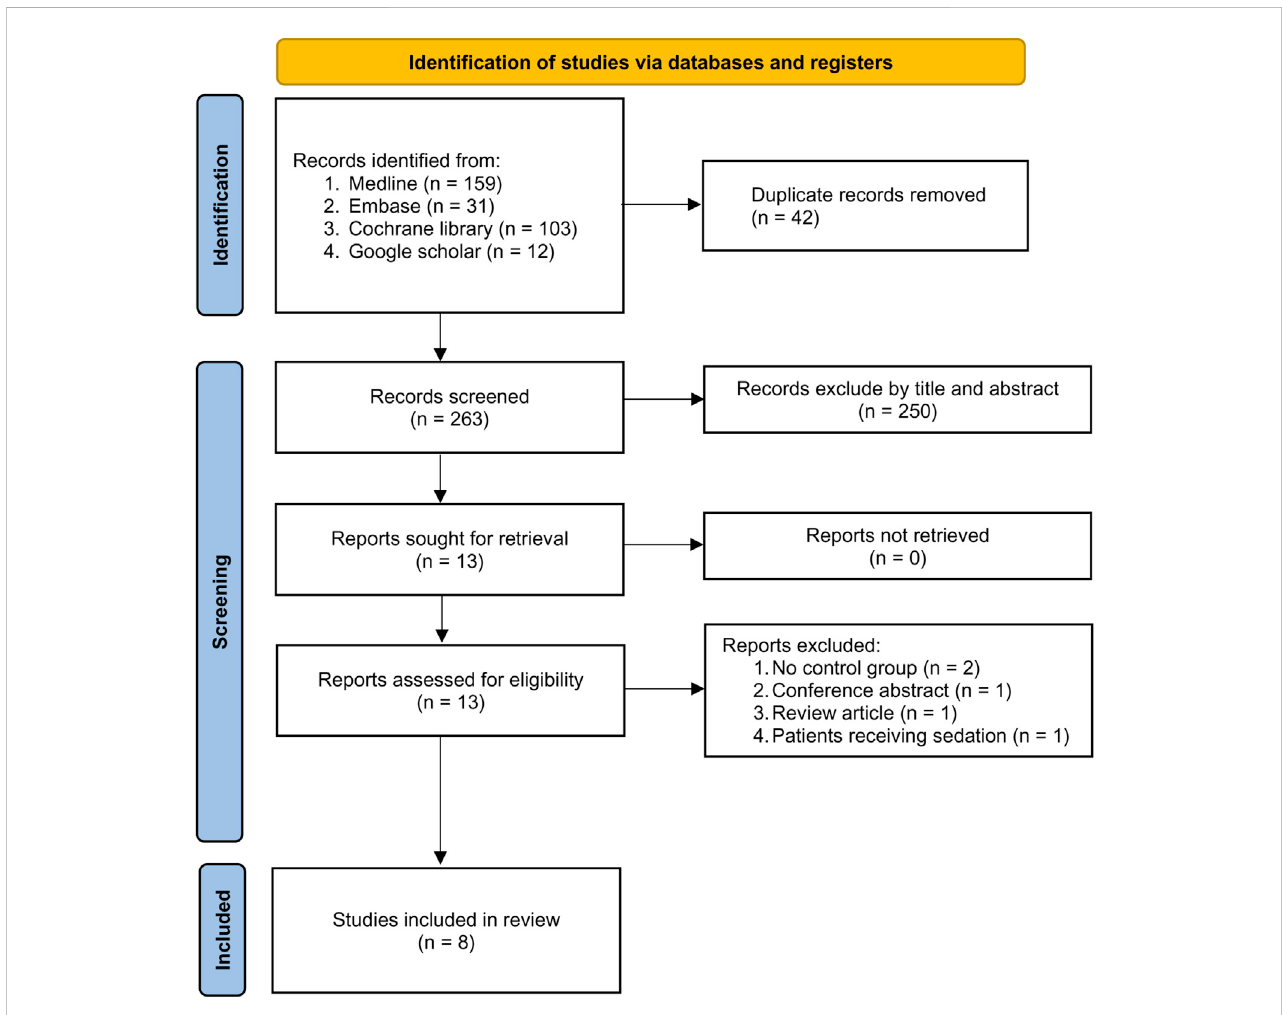
FIGURE 1 PRISMA fl ow diagram of study selection for the current